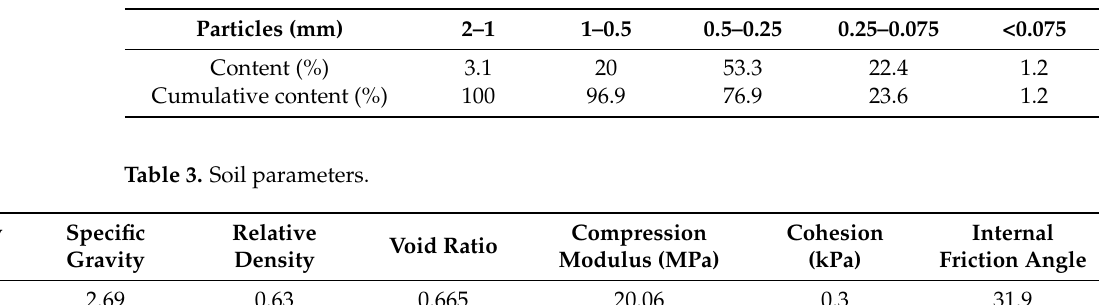
Table 2. Composition of sand particles.